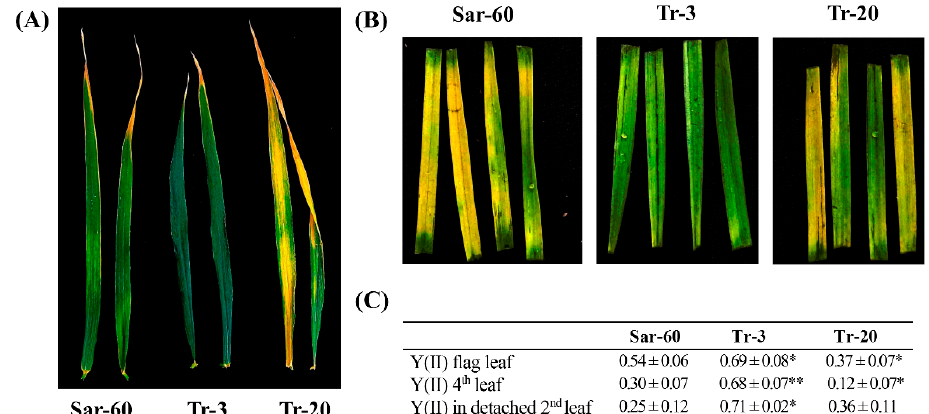
Figure 5. The timing of senescence is altered in wheat plants overexpressing AtOPR3. ( A ) Representative flag leaves of two-month-old homozygous T2 plants, Sar-60, Tr-3, and Tr-20. ( B ) The senescence of detached leaves. Same-aged detached leaves of Sar-60, Tr-3, and Tr-20 were kept floating on distilled water in Petri dishes under photoperiodic illumination 16/8 hr (light/dark). The picture was taken on the fifth day of the experiment. ( C ) Analysis of PS II operating efficiency in flag (upper line) and fourth (middle line) leaves of two-month-old Sar-60, Tr-3, and Tr-20 plants growing in the soil, and detached leaves kept for five days under photoperiodic illumination (bottom line). Means of 13–16 measurements ± SE are presented. Stars indicate statistically significant differences from Sar-60 (* p ≤ 0.05, ** p ≤ 0.001).